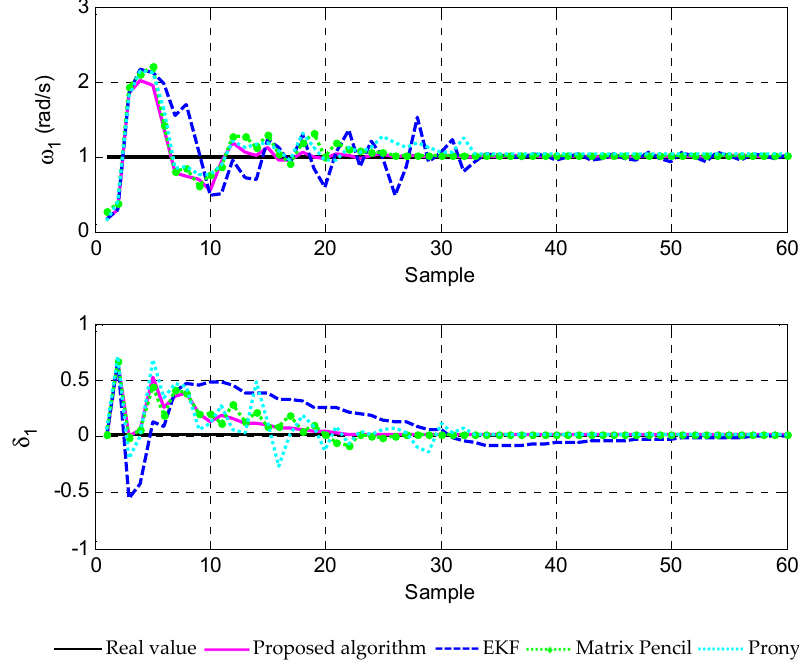
Figure 1. The input signal of test system 1.